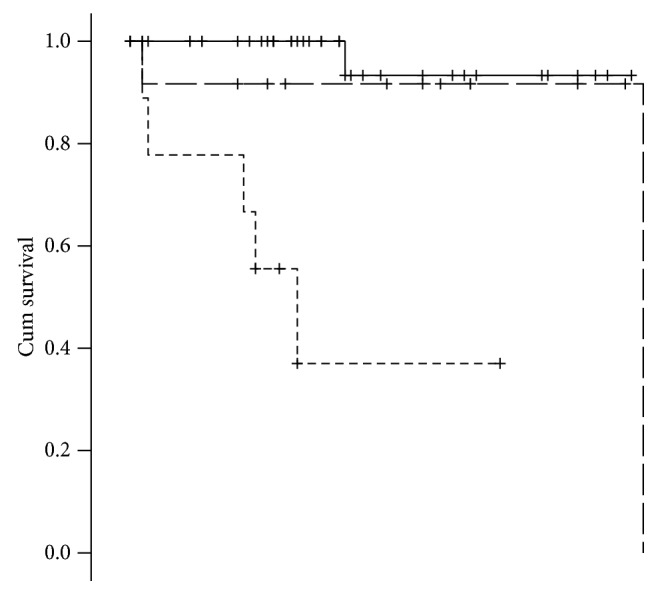
DFS Kaplan-Meier for lymph node involvement proposed categorization. p < 0.001; mean survival, N0: 81.800 (75.741-87.859); N1: 80.000 (61.423-98.577); N2: 34.148 (17.417-50.879).